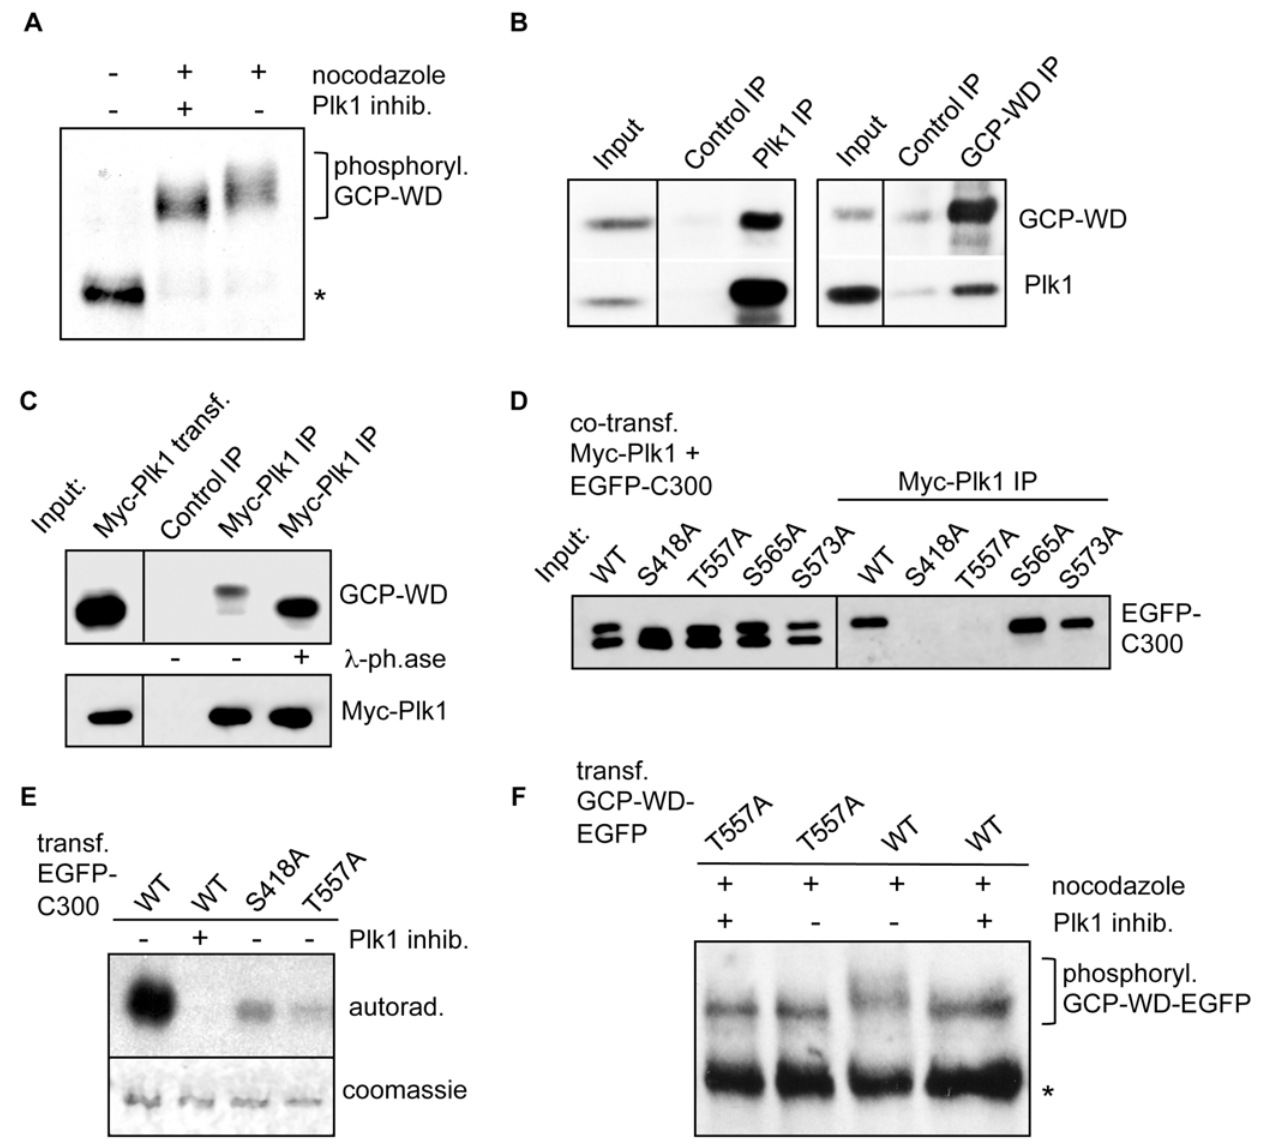
Figure 2. Plk1 interacts with GCP-WD in mitosis and contributes to its mitotic phosphorylation. (A) Hela cell lysates immunoblotted for GCP-WD. Cells were synchronised in mitosis by nocodazole treatment. BI2536 was added for 90 min before harvesting the cells by shake-off. The asterisk indicates the position of unphosphorylated GCP-WD. (B) Coimmunoprecipitation of endogenous GCP-WD and Plk1. Proteins were immunoprecipitated from mitotic lysates obtained from nocodazole-arrested HeLa cells after shake-off with antibodies against HA (Control IP), Plk1 and GCP-WD, as indicated. Precipitates were separated by gel electrophoresis, blotted and probed with anti-GCP-WD and anti-Plk1 antibodies. (C) Myc-tagged Plk1 was immunoprecipitated from extracts prepared from asynchronously growing HeLa cells after transient transfection. Unspecific mouse IgG was used as a control (Control IP). Precipitates were treated either with buffer alone or with l -phosphatase and analyzed by westernblotting with anti-Myc and anti-GCP-WD antibodies. (D) After cotransfection of Myc-tagged Plk1 with C-terminal EGFP-tagged wildtype or mutant fragments of GCP-WD (EGFP-C300) in HeLa cells, Myc-tagged Plk1 was immunoprecipitated from non-synchronous cultures and precipitates were immunoblotted using anti-GFP antibody. (E) EGFP-tagged C-terminal GCP-WD wt or mutant fragments were transiently expressed in HeLa cells and immunoprecipitated after nocodazole treatment. Precipitates were subjected to an in vitro phosphorylation assay in the absence or presence of BI2536 to inhibit Plk1 activity. After SDS-PAGE the immunoprecipitated proteins were detected by coomassie staining, incorporation of [ c -32P] was detected by autoradiography. (F) Lysates from U2OS cells expressing EGFP-tagged GCP-WD wt or T557A mutant were immunoblotted for GCP-WD. Cells were synchronized in mitosis by nocodazole treatment. BI2536 was added for 90 min before harvesting the cells by shake-off. The asterisk indicates the position of unphosphorylated GCP-WD-EGFP.